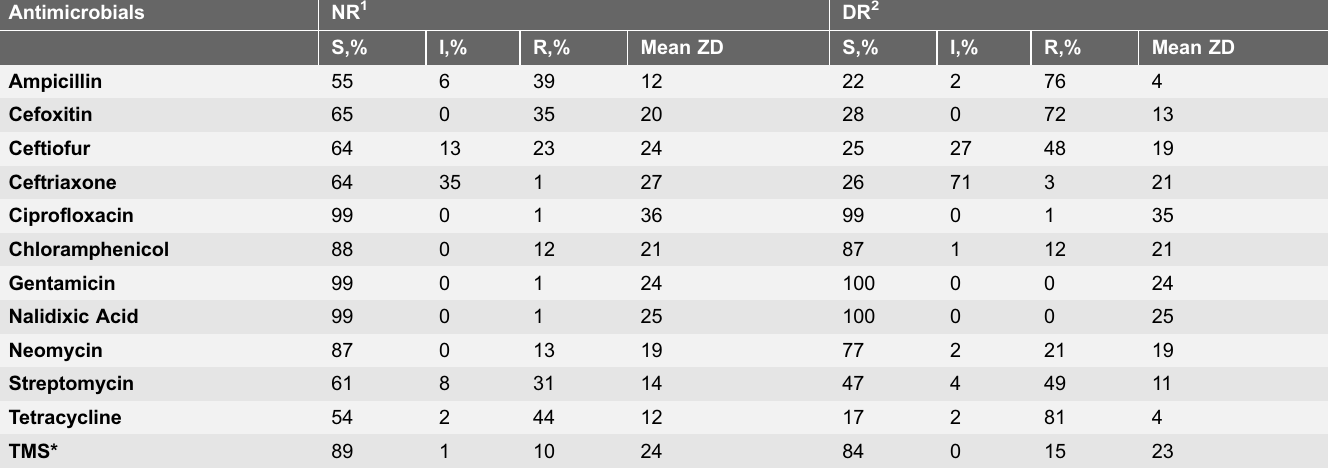
Table 1. SIR distribution of E. coli and mean disk diffusion zone diameter (ZD) by milk feeding treatment group. Antimicrobials NR 1